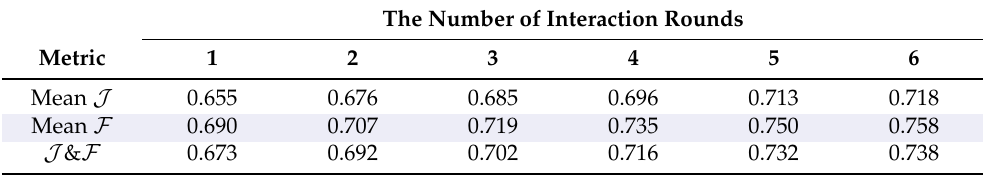
Table 10. Performance on the validation set in DAVIS2017 according to the number of interaction